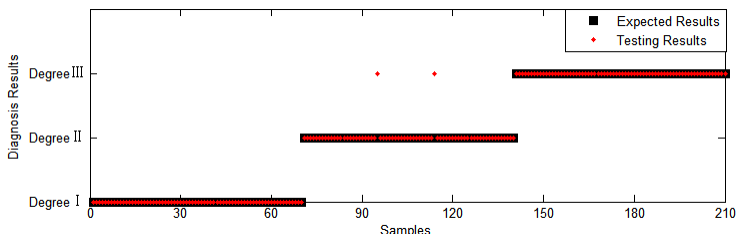
Figure 14. Diagnosis results of ball fault severity estimation based on the BPNN_BA network and decision fusion.